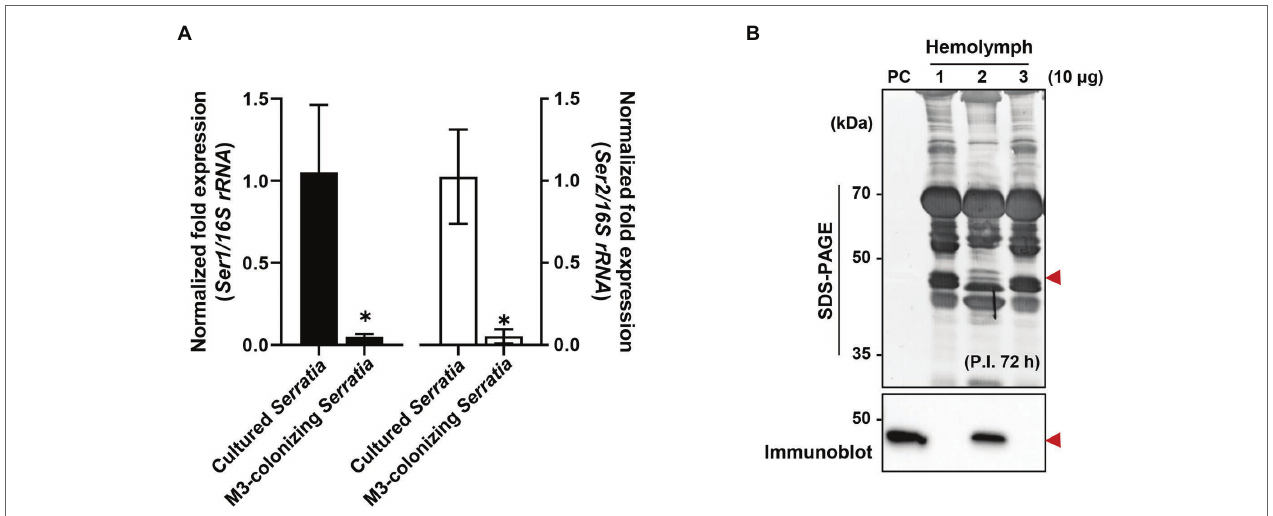
FIGURE 6 | Suppression of serralysin production in M3-colonizing Serratia marcescens cells. (A) The mRNA expression levels of serralysin genes in cultured S. marcescens and M3-colonizing S. marcescens . The expression levels of serralysin genes were normalized to the expression levels of each cultured S. marcescens , which was set as 1. Data are expressed as the mean ± SD ( n = 4). (* p < 0.01; unpaired t -test). The Genbank accession numbers of protein sequences are as follows: serralysin 1 (CDG14870.1) and serralysin 2 (CDG11942.1). (B) SDS-PAGE (upper layer) and immunoblot (bottom layer) of whole-body hemolymph after systemic injection of S. marcescens into male Sym insects. Serratia marcescens cells (1.0 × 10 5 CFUs) systemically injected into 3-day-old adult male Riptortus pedestris insects for immune induction. After injection for 3 h at 28 ° C, immune-challenged hemolymph was collected from the insects, and induction of serralysin was analyzed using specific antibodies. Arrowheads indicate the bands of purified serralysin. PC: purified serralysin (0.5 μ g). Columns 1, 2, and 3 indicate phosphate- buffered saline (PBS) injection, cultured S. marcescens injection, and M3-colonizing S. marcescens injection,